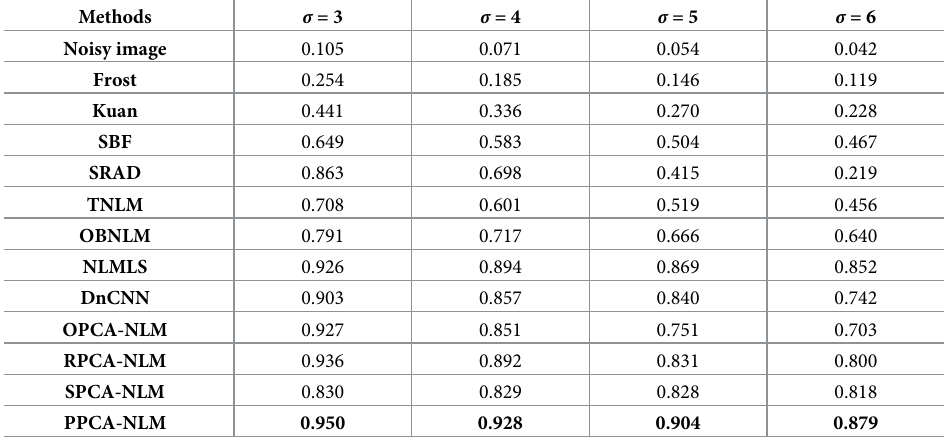
Table 2. The SSIM values of various despeckling methods on the synthetic image.